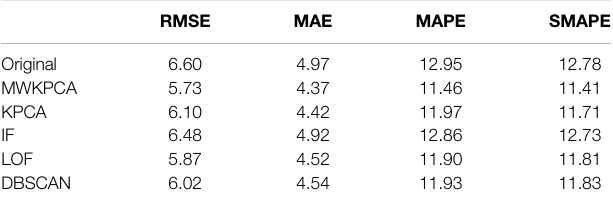
TABLE 2 | Prediction errors.